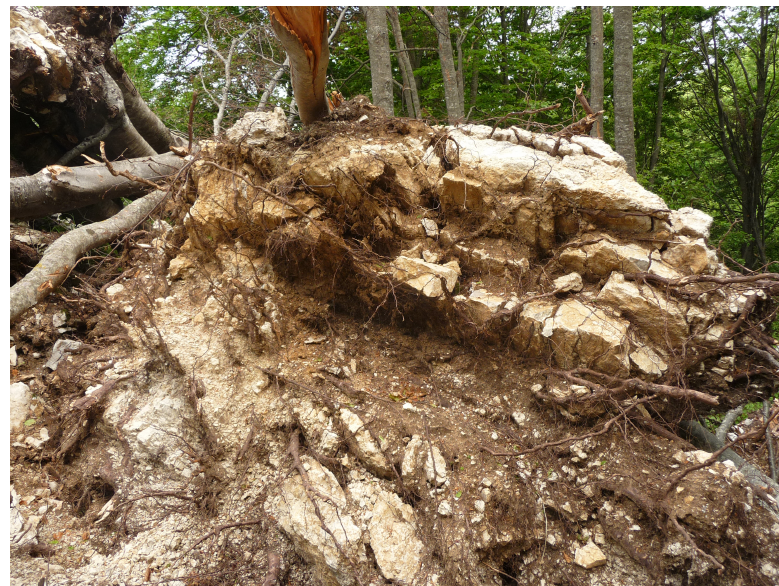
Figure 8. Root system of an uprooted tree, showing how the roots permeate the soil and karstic